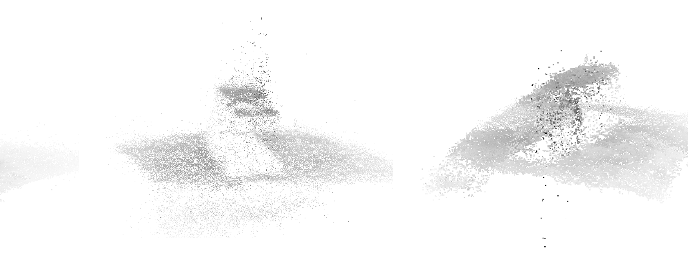
Figure 8. Single shot point cloud results of the convergent acquisition geometry.